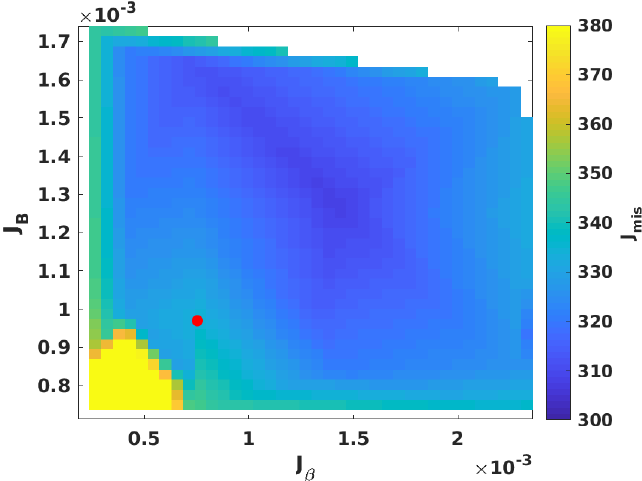
Figure A3. An L -surface for STREAMICE, produced for a previous project, which was used as the basis for regularisation choices in this work. The chosen values lie at the red